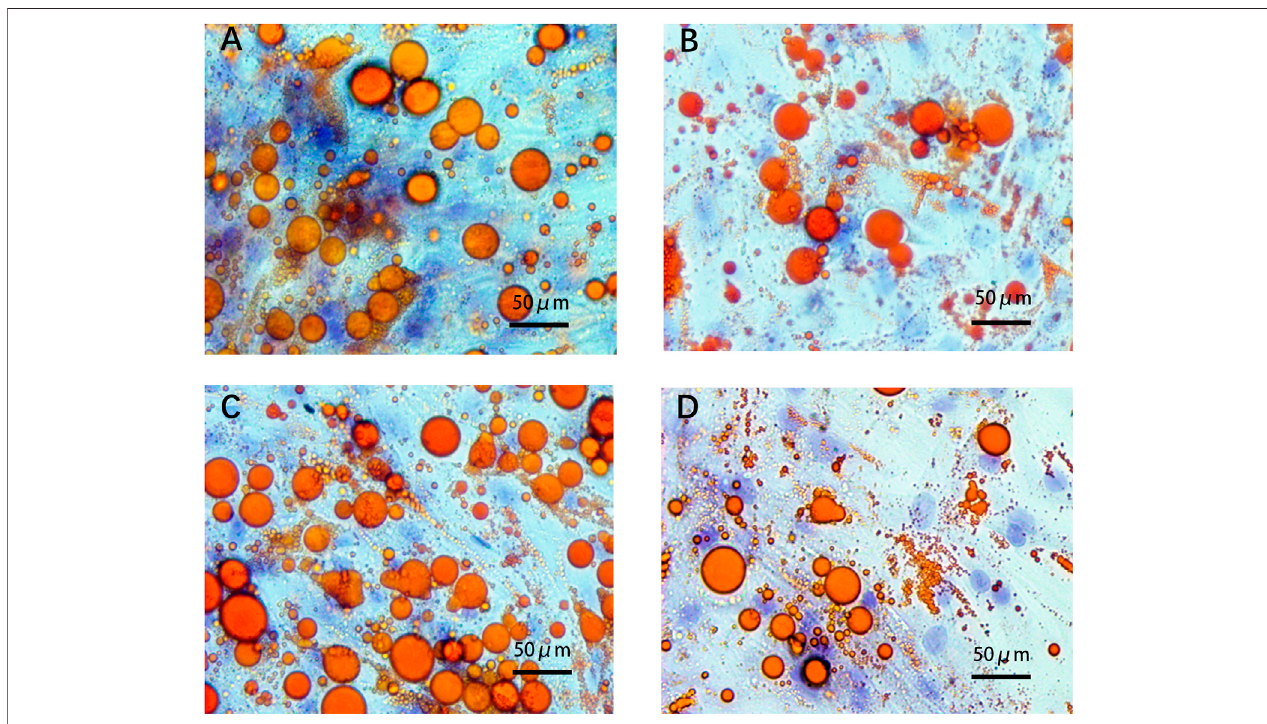
FIGURE 6 | ADSCs assessed using Oil Red O staining. (A) . Low-fat non-ADE group; (B) Low-fat ADE group; (C) High-fat non-ADE group; and (D) High-fat ADE group. Groups treated with ADEs had fewer and smaller lipid droplets than the non-ADE